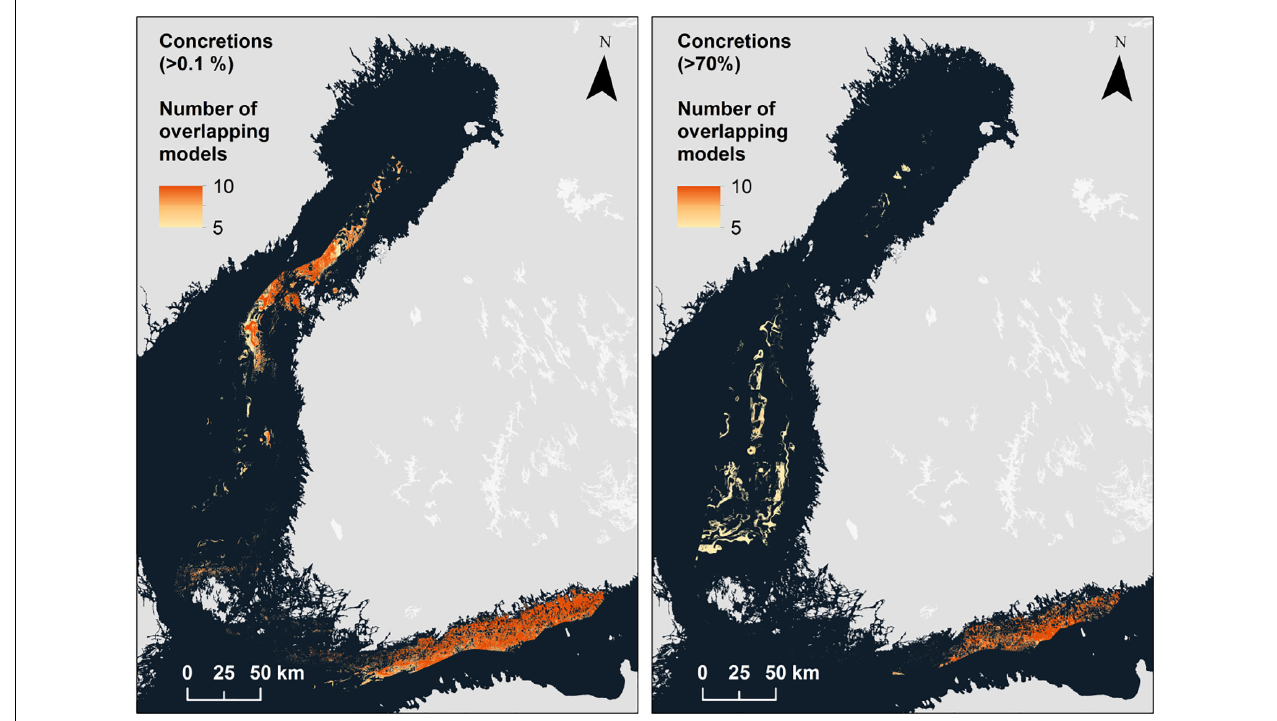
FIGURE 6 | Concretion prediction maps for concretion occurrences ( > 0.1%) and concretion fields ( > 70%).